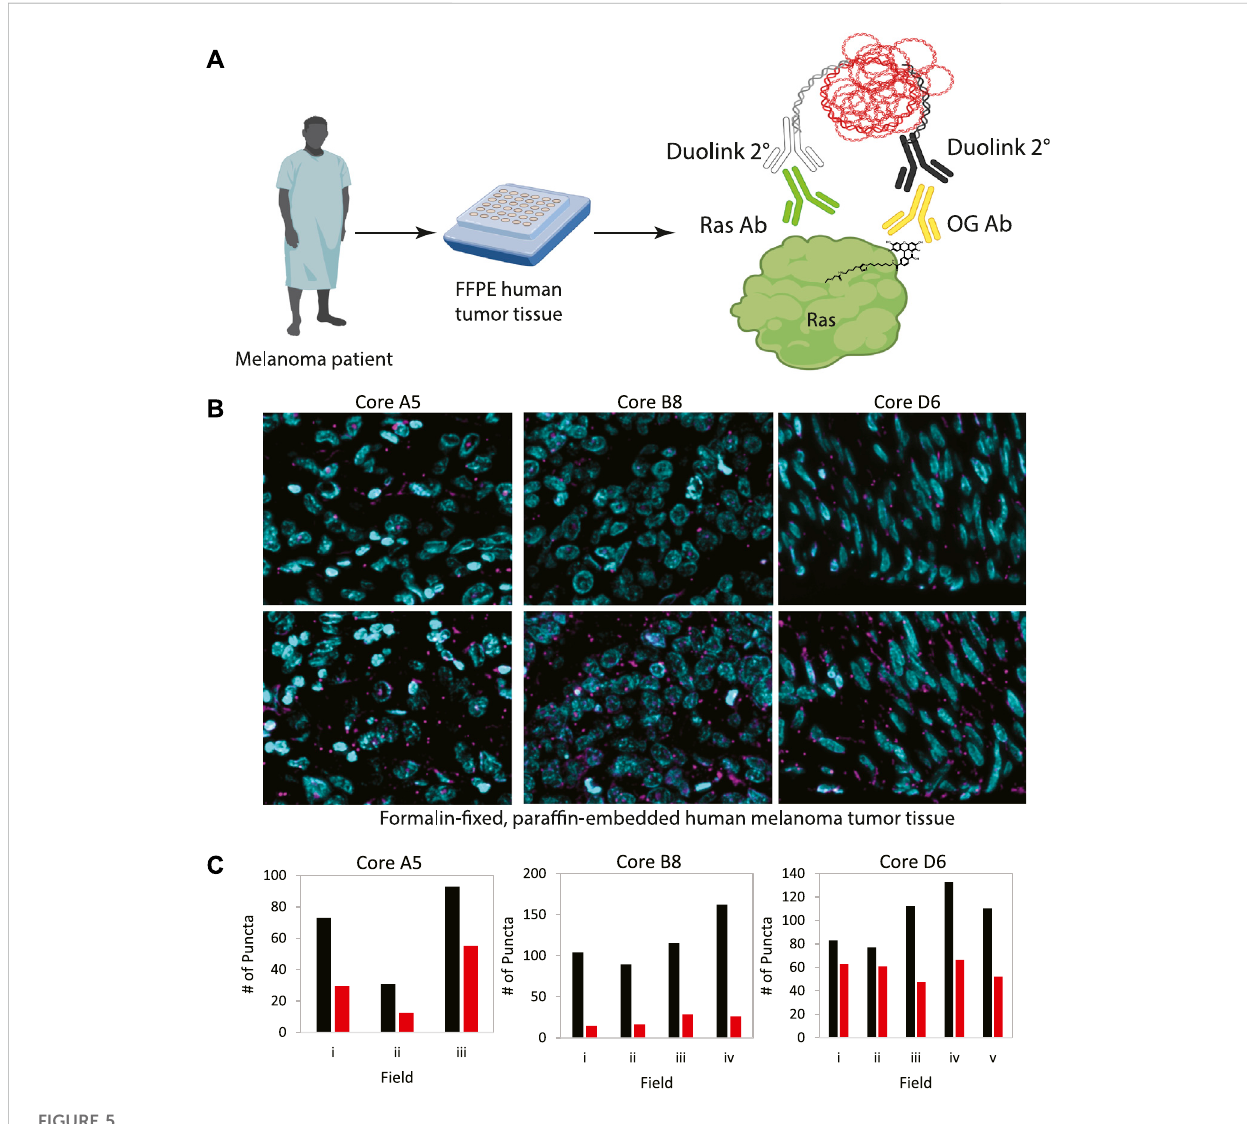
FIGURE 5 (A) Work fl ow for analysis of patient tumor samples on a tissue array. (B) Melanoma tissue arrays were treated with the ABE-PLA. Three different samples are shown. (C) The number of PLA puncta (magenta) per fi eld were counted in the -HAM control slide and the +HAM treated slide. Variation in backgroundsignal(-HAM,Redbars)betweensamplesandbetween fi eldswithinasampleareshowncomparedtotheABEgeneratedsignal(+HAM,Black bars). Statistical signi fi cance of the difference between – HAM and + HAM samples: A5 p -value = 0.049, B8 p -value = 0.006, D6 p -value = 0.015; Paired Student ’ s T